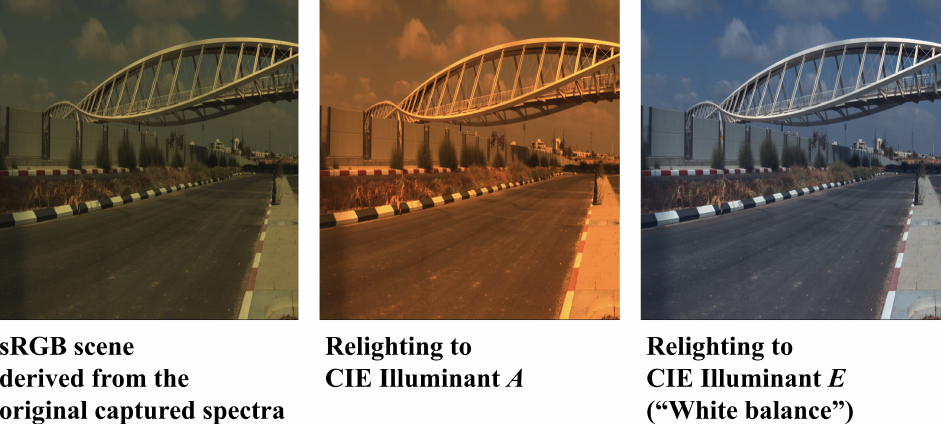
Figure 8. The original ( left ) and relighted scenes ( middle and right ) shown in sRGB